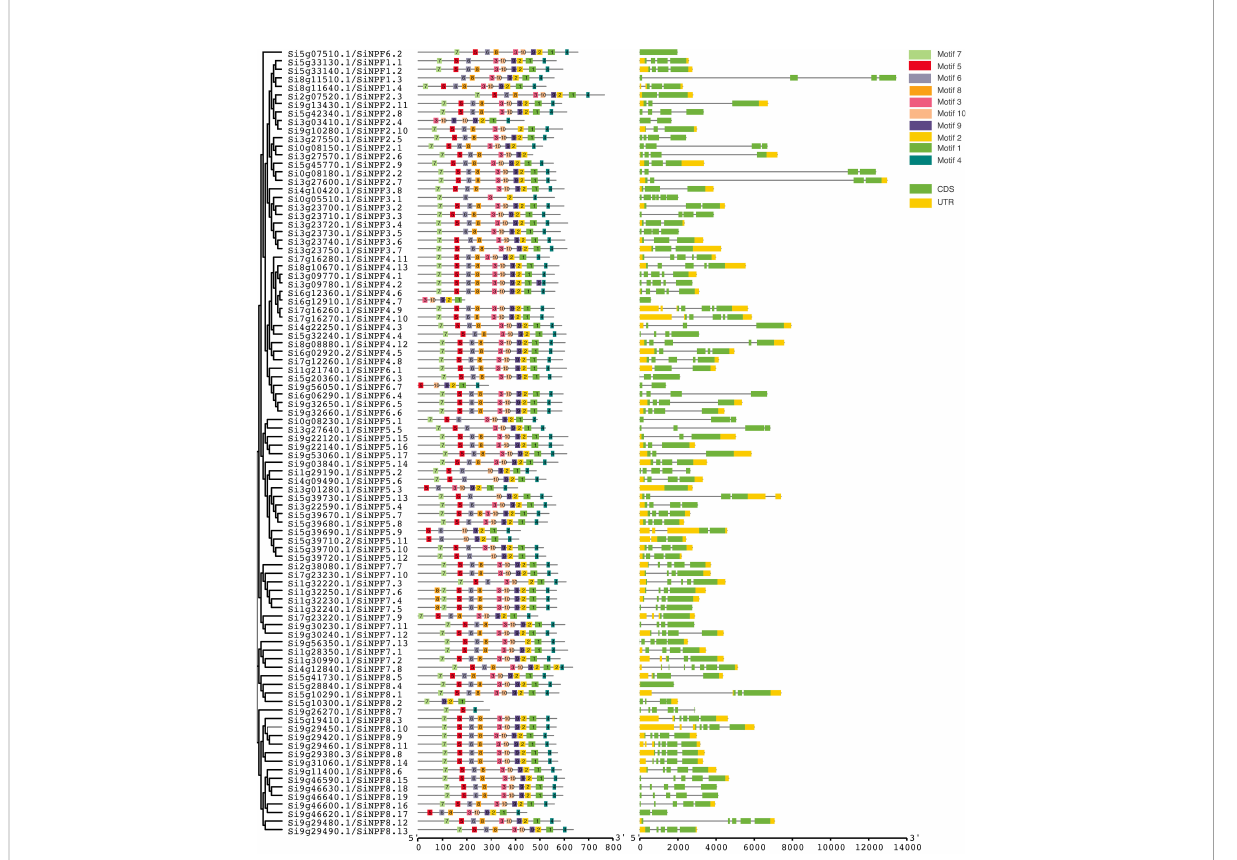
FIGURE 3 Phylogenetic relationship, gene structure analysis, and motif distributions of SiNPF genes. Exon-intron structures are customized in each subfamily (with customized scale bar), the green bar represents exons, the black line represents introns, and the yellow bar represents UTR (untranslated region). The different motifs are color-coded as illustrated in the fi gure. The scale represents amino-acid